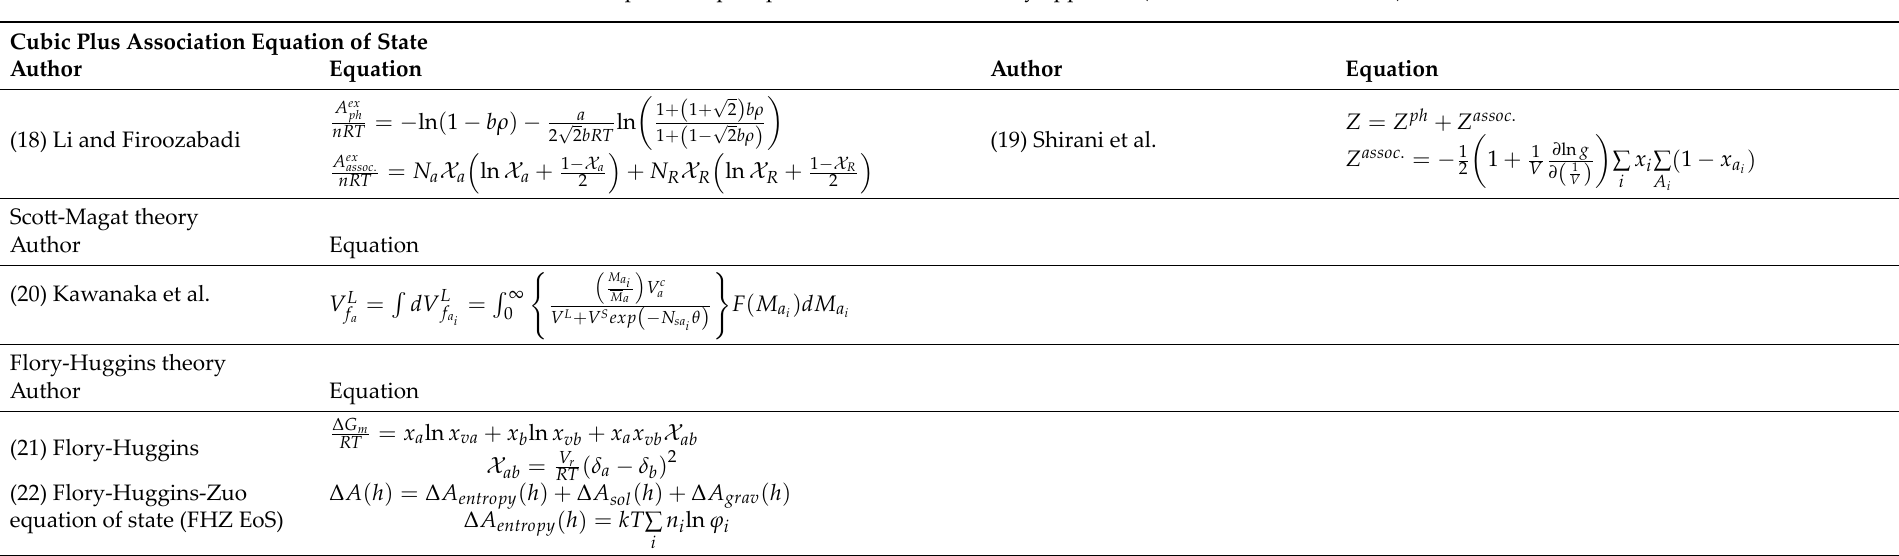
Table 3. Models to calculate asphaltene precipitation based on solubility approach (CPA‑EoS, SMT, and